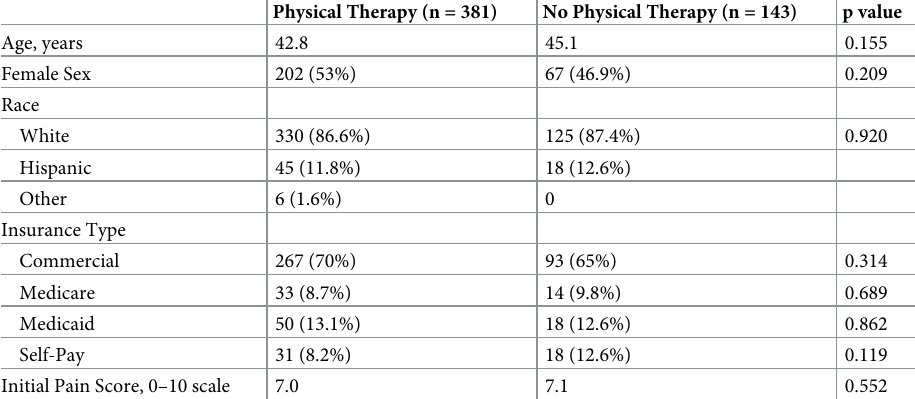
Table 1. Baseline characteristics of study